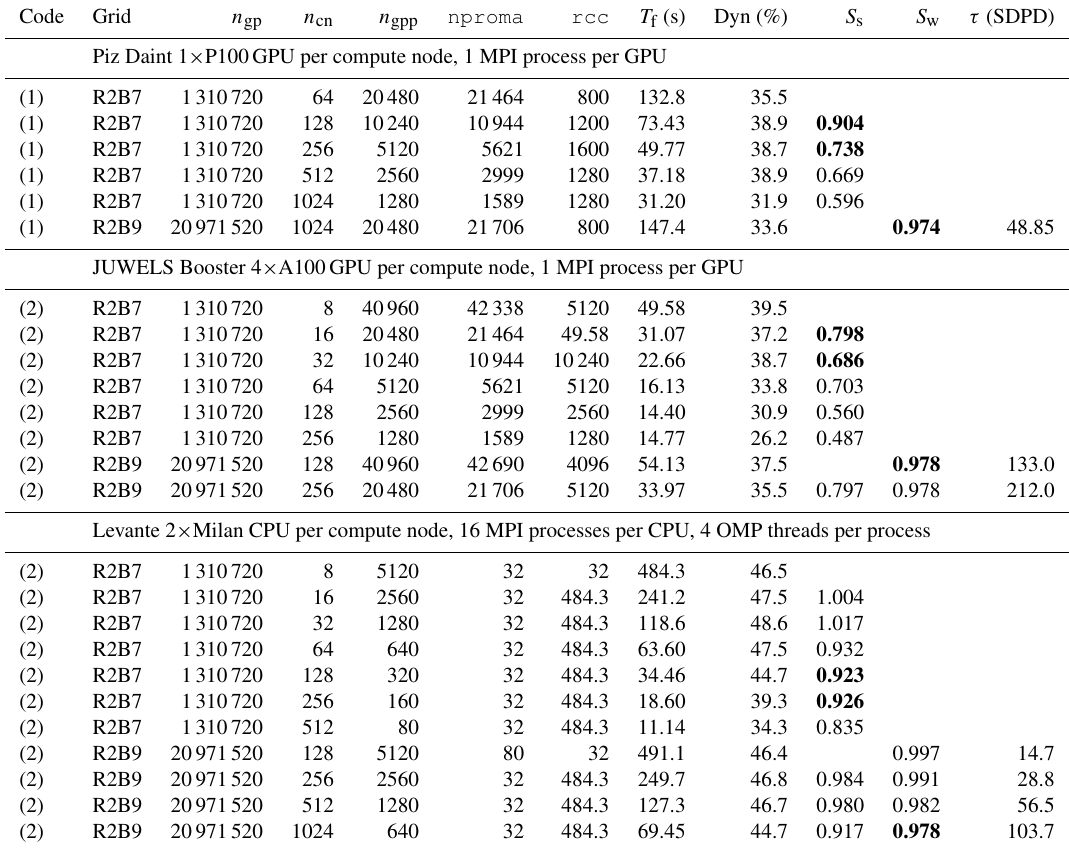
Table 3. Time to solution, T f ; percent of time spent on dynamical solver (Dyn); strong and weak scaling, S s and S w respectively; and temporal compression, τ, for experiments on Piz Daint, JUWELS Booster, and Levante with code version (Code) from Table 2, grid name, number of grid points, n gp , number of computing nodes, n cn , number of grid points per MPI process, n gpp , and optimization parameters, nproma and rcc . Scaling values shown in bold are used in the extrapolation for a 1 SYPD simulation at ca. 1km resolution; see Sect. 6.5.1. The temporal compression is only shown for the R2B9 setup, to which the chosen time step (40s)